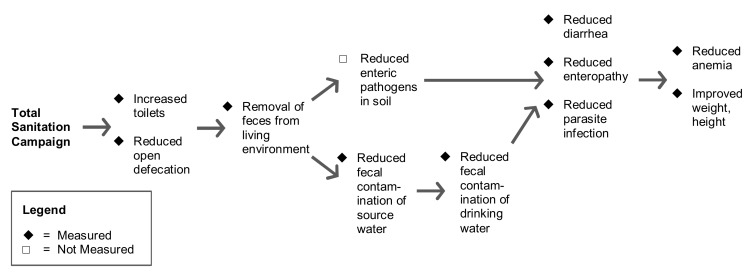
Hypothesized causal pathways for intervention impact and measurements.